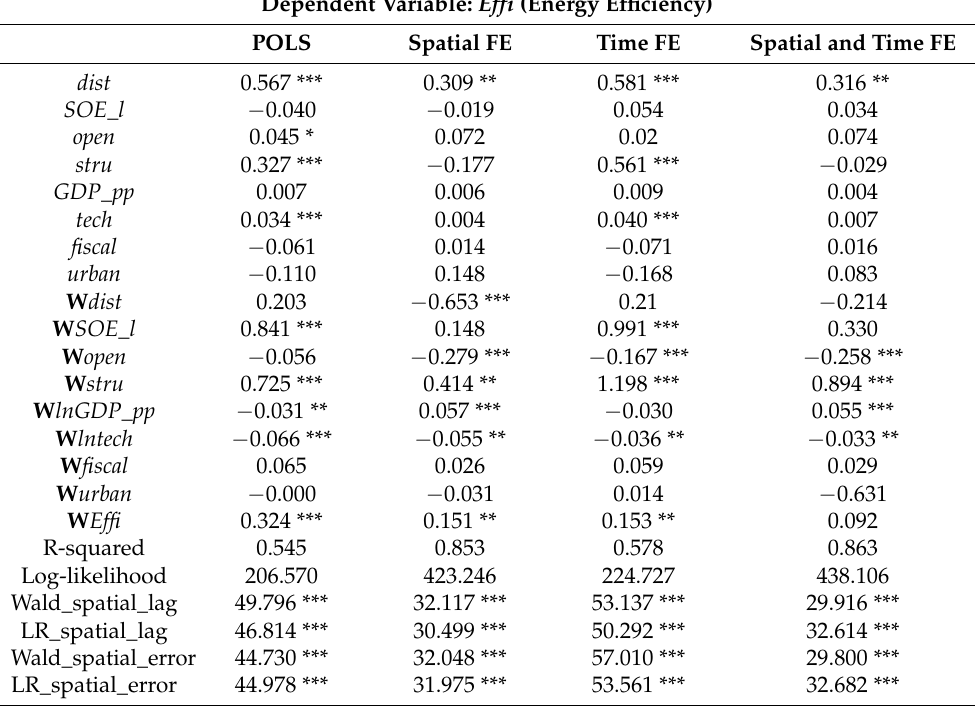
Table 2. Estimation results of the static spatial